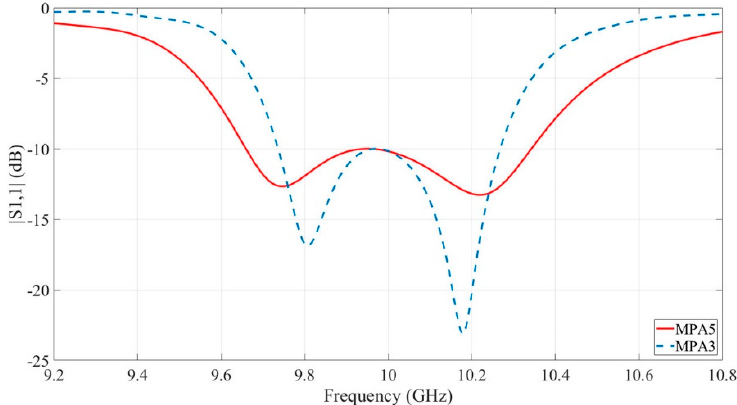
Figure 12. Simulated reflection coefficient for MPA3 and MPA5.